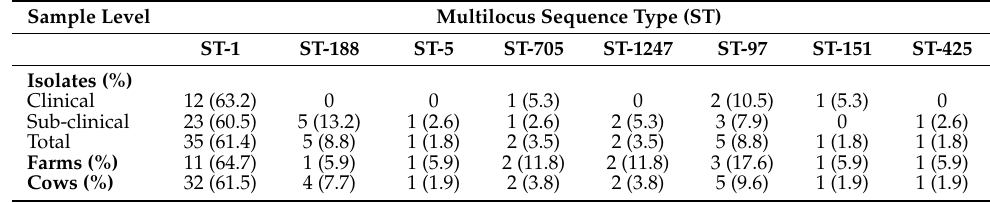
Table 1. Isolate-level ( n = 57), farm-level ( n = 17) and cow-level ( n = 52) prevalence of eight Staphy- lococcus aureus whole-genome multi-locus sequence types (MLST) isolated from the Waikato region of New Zealand North Island.